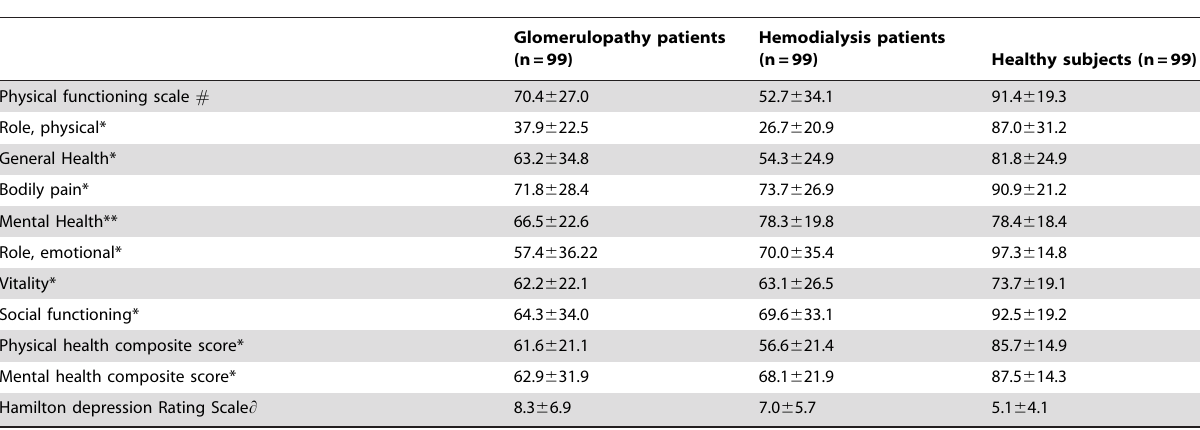
Table 2. SF-36 HRQoL and HAMD comparison between glomerulopathy and hemodialysis patients and healthy subjects.